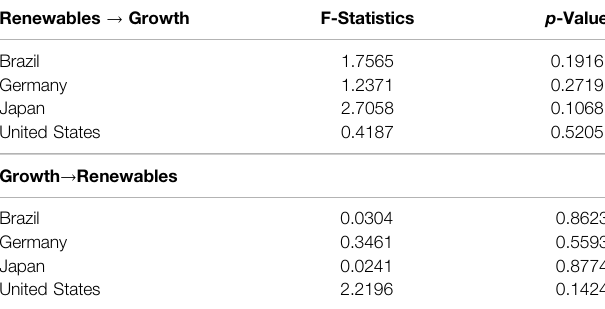
TABLE 1 | Traditional Granger causality test. Renewables →